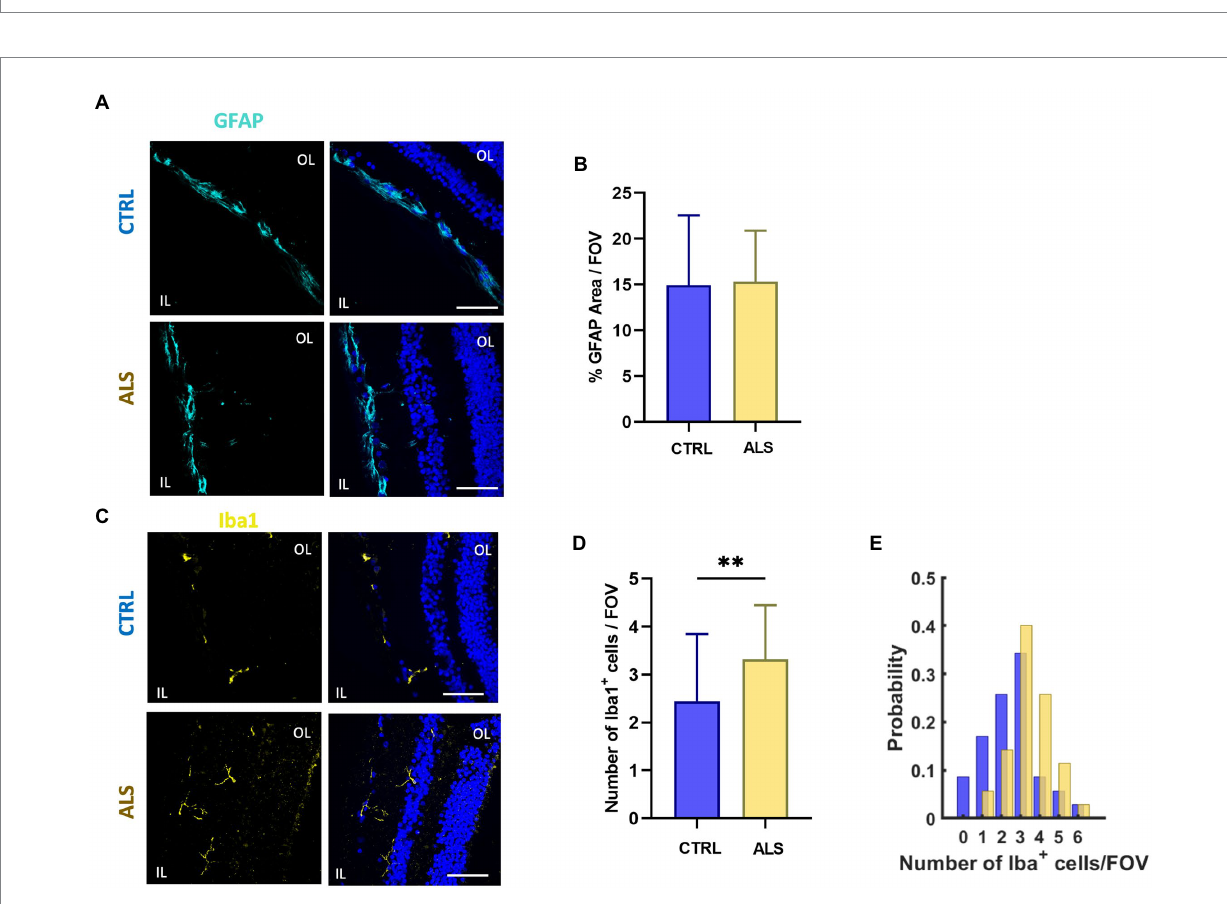
FIGURE 4 Astrocyte and microglia reactivity is not altered in ALS human retina. (A) Representative images of retinal slices from ALS patients and healthy controls immunolabeled with anti-GFAP (cyan); Hoechst was used for nuclei visualization (blue); scale bar 50 μ m. (B) Bar chart showing the percentage of the area covered by GFAP signal/field of view (ALS: n = 20/4 fields/patients; CTRL n = 18/4 fields/patients). (C) Representative images of retinal slices from ALS patients and control cases immunolabeled with anti-Iba1 antibody (yellow) and Hoechst for nuclei visualization (blue); scale bar 50 μ m. (D) Bar graph displaying the number of Iba1+ cells for each field of view (ALS n = 35/6 fields/patients; CTRL n = 36/6 fields/patients; ** p < 0.01). (E) Distribution of the number of retinal microglia cells in each field of view (400 μ m 2 ) in ALS patients (yellow) and age matched controls